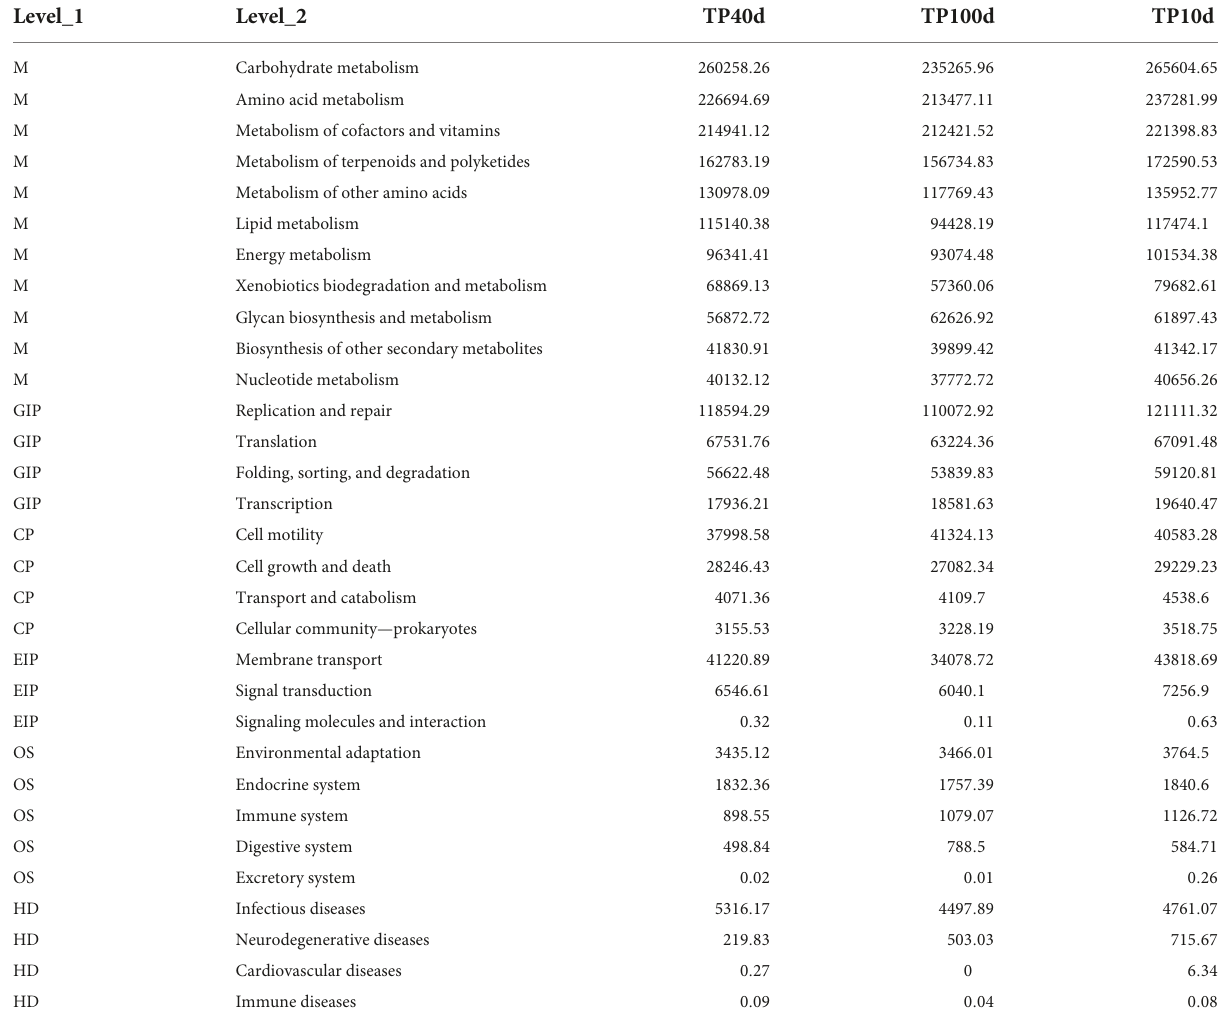
TABLE 2 Functional prediction of three groups of Tibetan pigs at different growth